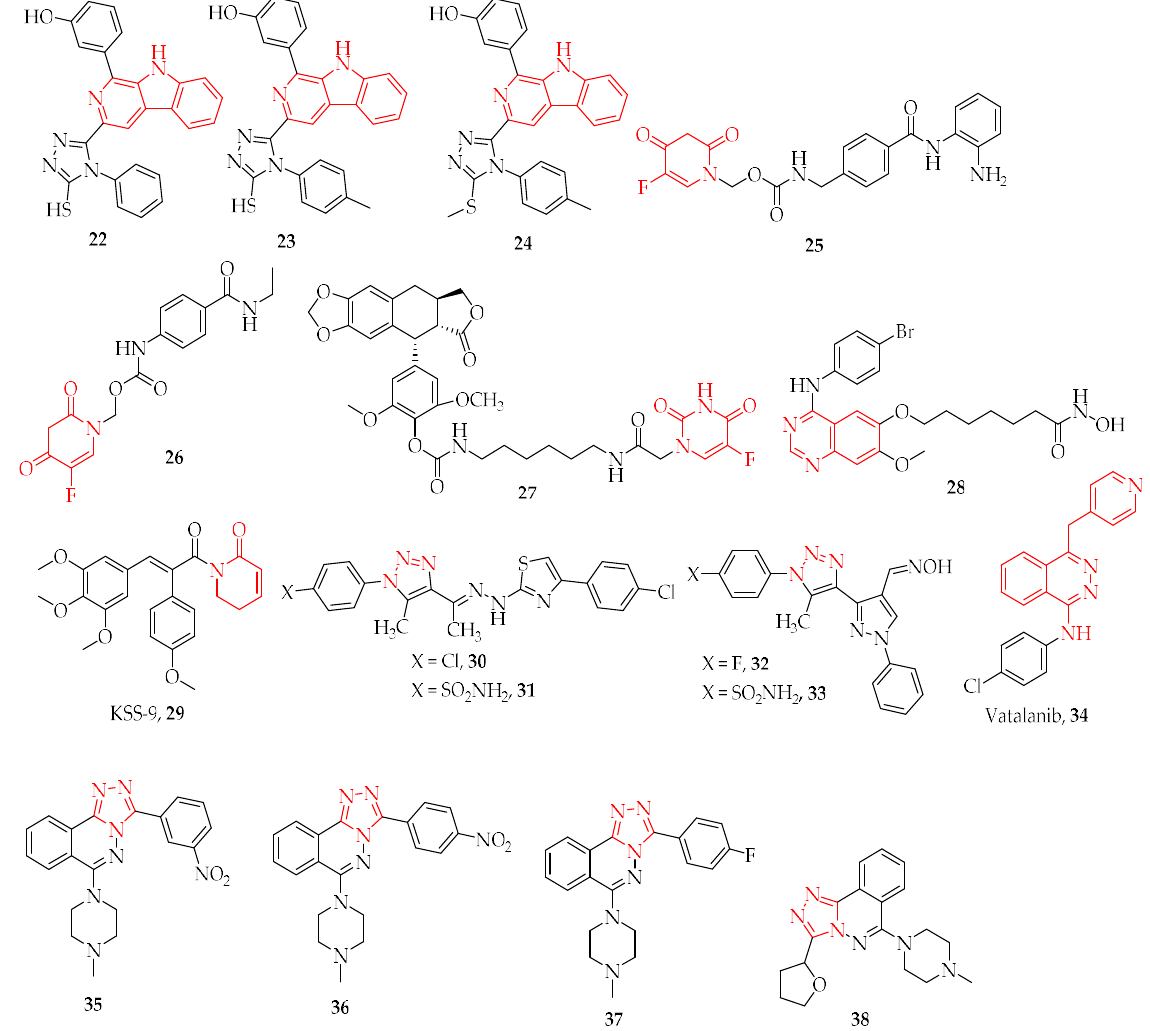
Figure 4. Examples of synthesized multi-target anticancer N -based heterocyclic compounds.